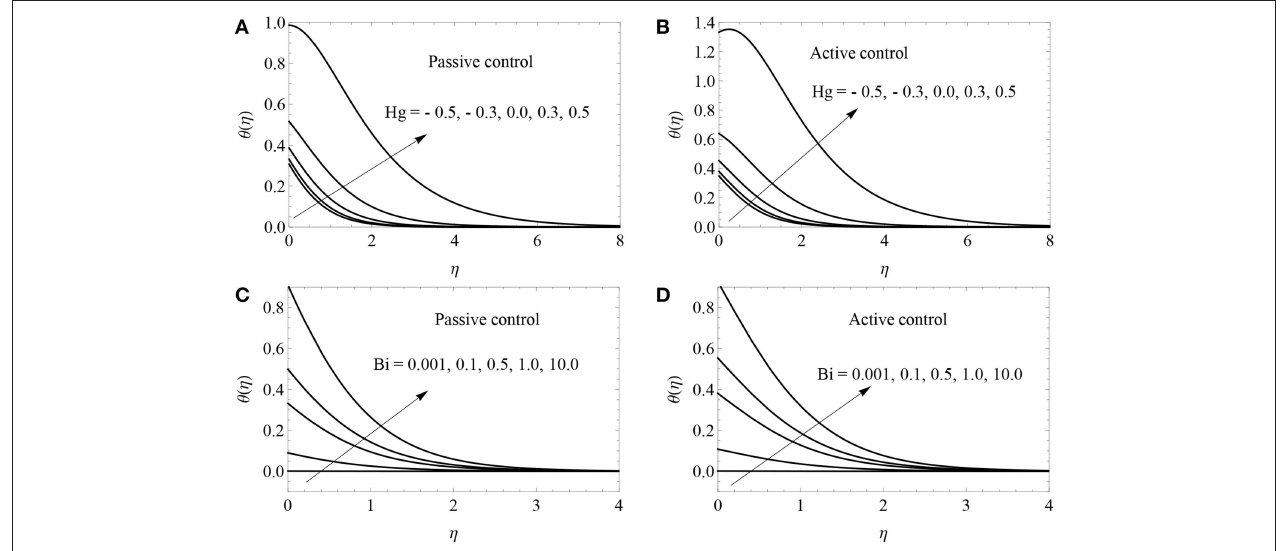
FIGURE 5 | Temperature profile for different values of Hg (A,B) and Bi (C,D) for both passive and active cases with K